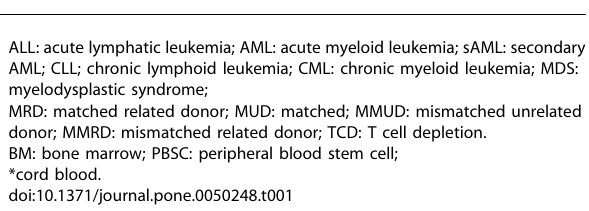
Table 1. Patient